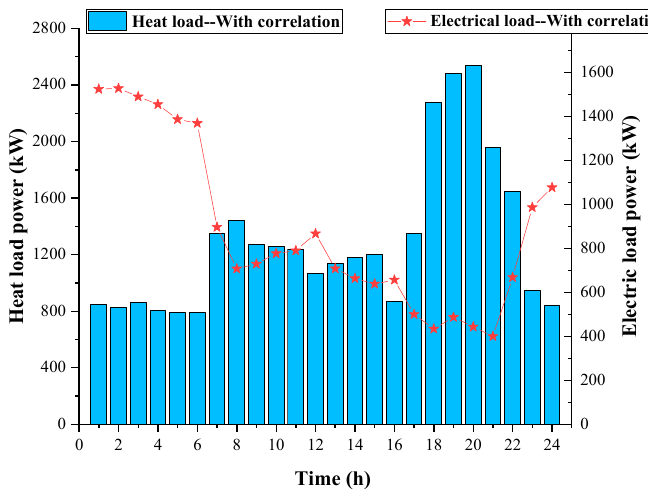
Figure 11. EH load demand with and without correlation.